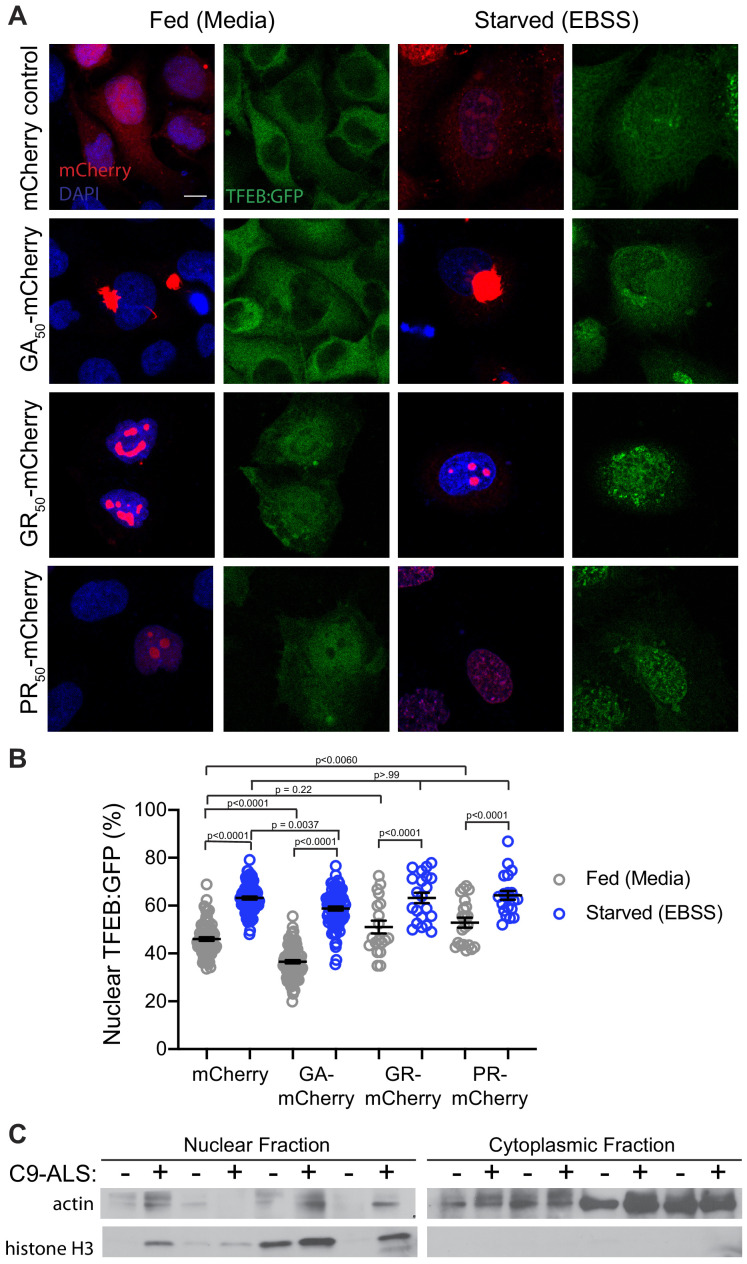
DPRs affect TFEB import in HeLa Cells.(A) Representative images of transfection of codon-optimized poly-GA-mCherry, poly-GR-mCherry, and poly-PR-mCherry into HeLa cells with stably incorporated TFEB:GFP. (B) Quantification of percent nuclear TFEB:GFP in A. Data are presented as mean ± SEM. One-way ANOVA, p<0.0001, with Sidak’s multiple comparisons n = 80, 90, 92, 84, 19, 21, 21, and 21 cells, respectively. Scale bars = 20 µm. (C) Nuclear and cytoplasmic fractions of human motor cortex samples in Figure 7C blotted for cytoplasmic (beta-actin) and nuclear (histone H3) control proteins.